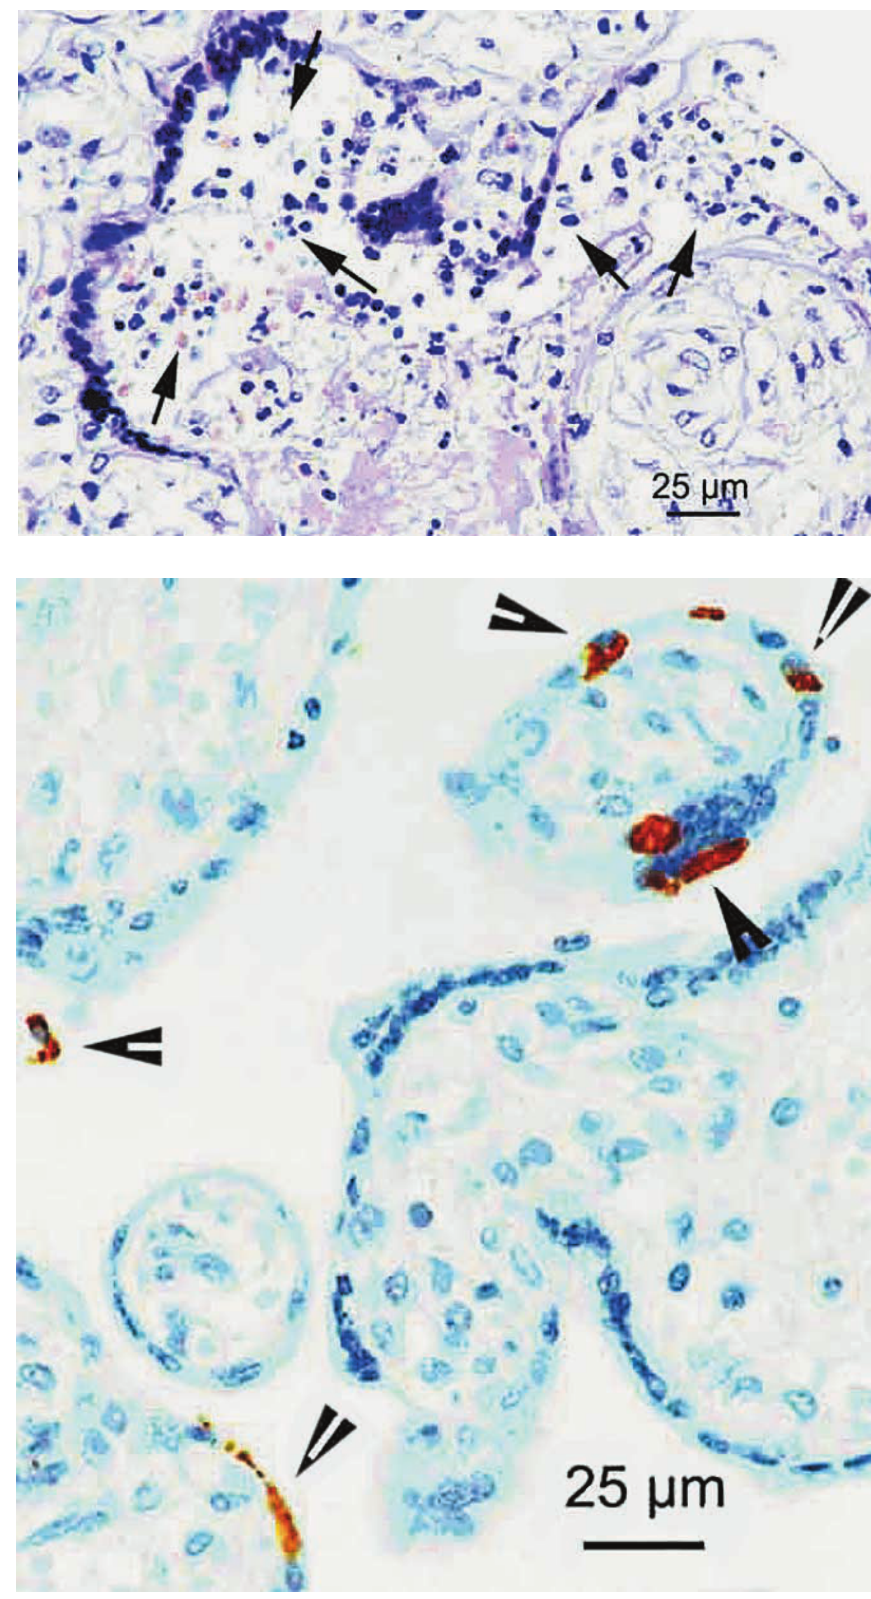
Figure 1 Histopathology of placental lesions: villitis acuta (arrows).